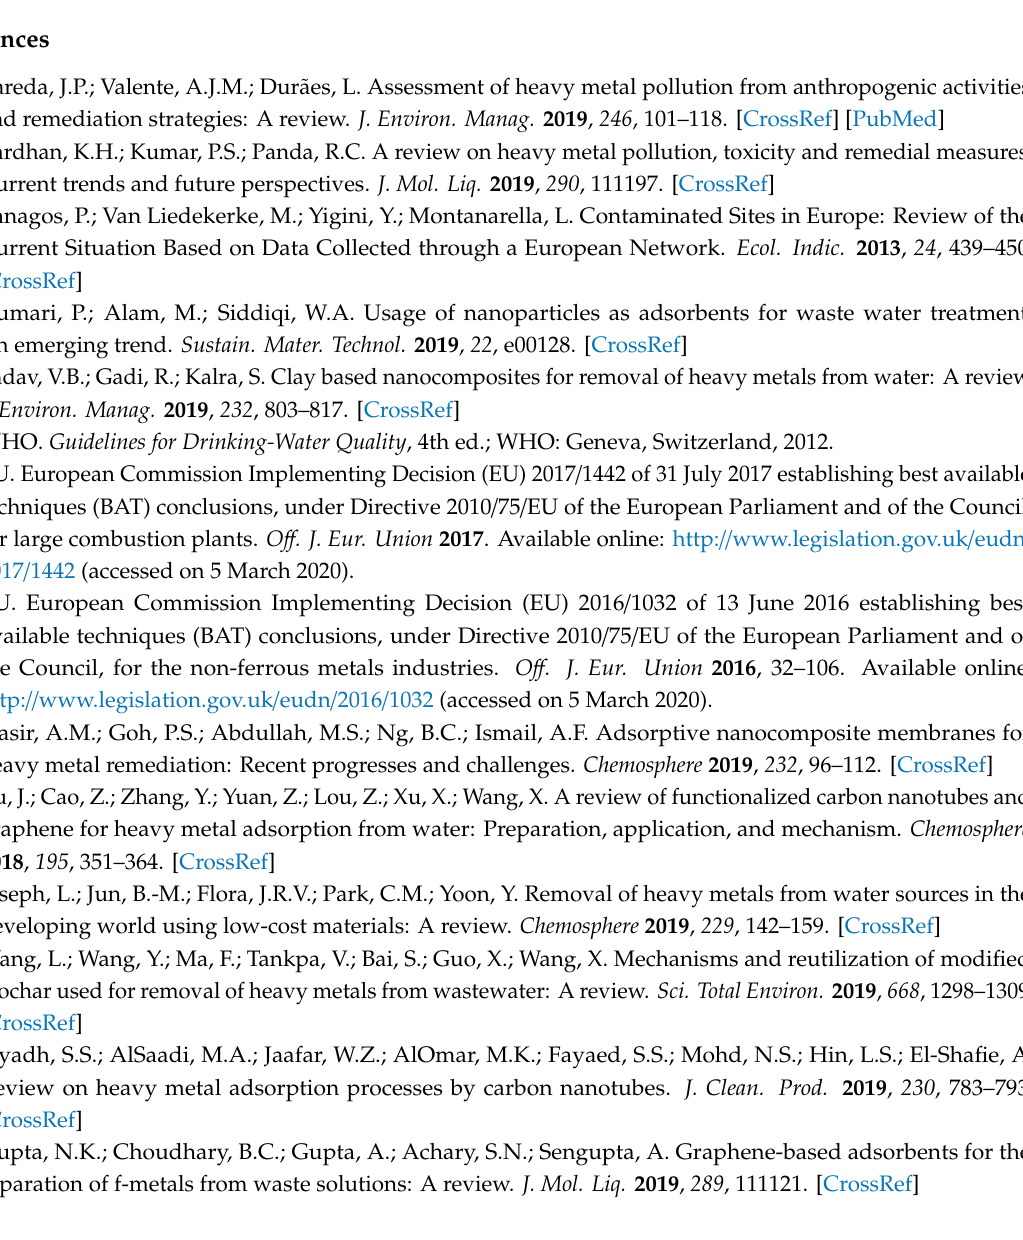
Figure S1: SEM images of: (a) oxMWCNT3h and (b) oxMWCNT6h., Figure S2: Points of zero charge of: ( a ) oxMWCNT3h and ( b ) oxMWCNT6h. Table S1: EDS analysis of oxMWCNT3h and